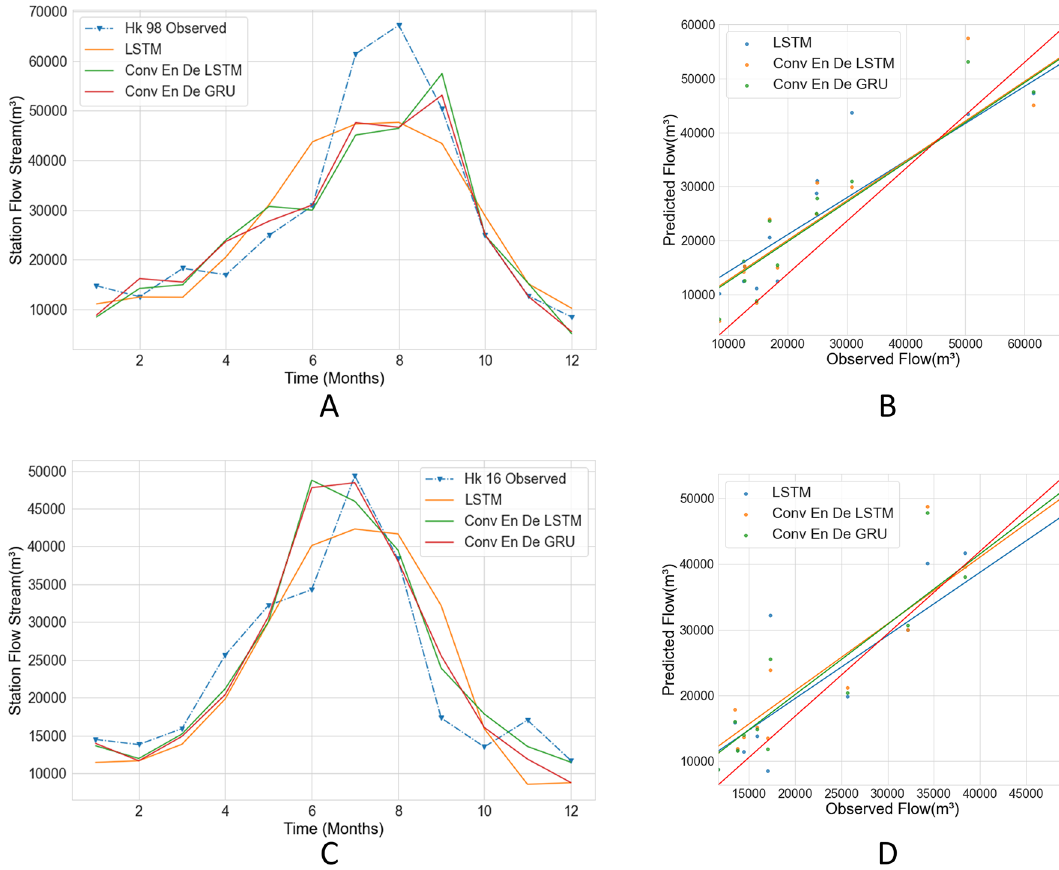
Figure 14. Comparison with different models in Hankou station. The solid lines in A, C plot the predicted values using different models, and the blue dashed lines are the observed values. ( B, D ) Scatter plots of predicted and observed values for three